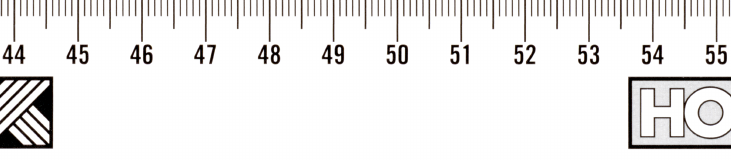
Figure 10. Picture of scanned black-and-white ruler.